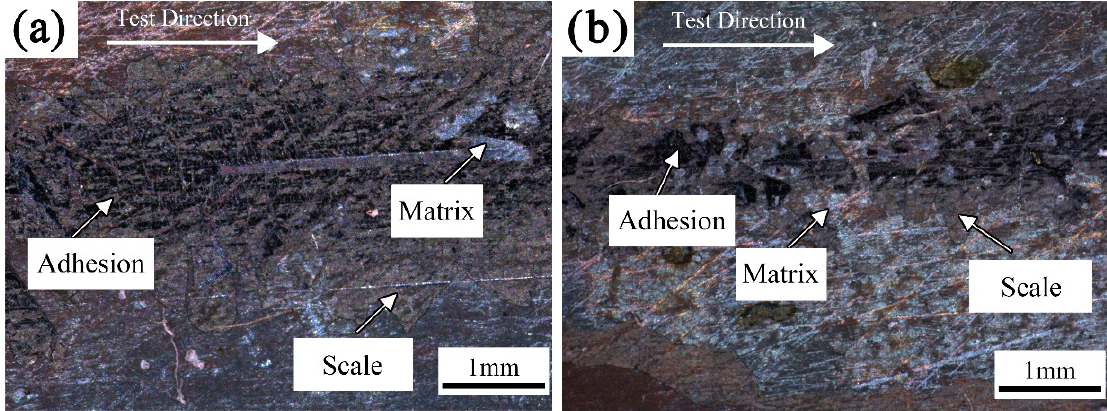
Figure 7. 3D digital images of worn surfaces, ( a ) 10Mn5; ( b ) 22MnB5.